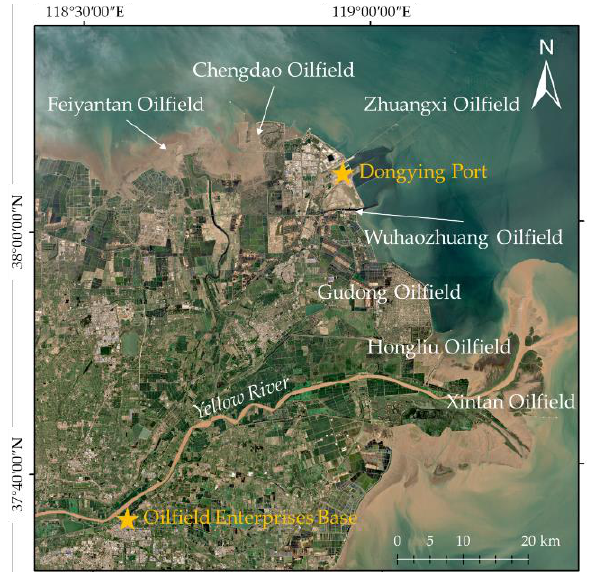
Figure 13. Coastal oilfields in the YRD, including Feiyantan (FYT), Chengdao (CD), Zhuangxi (ZX), Wuhaozhuang (WHZ), Gudong (GD), Hongliu (HL), and Xintan (XT)